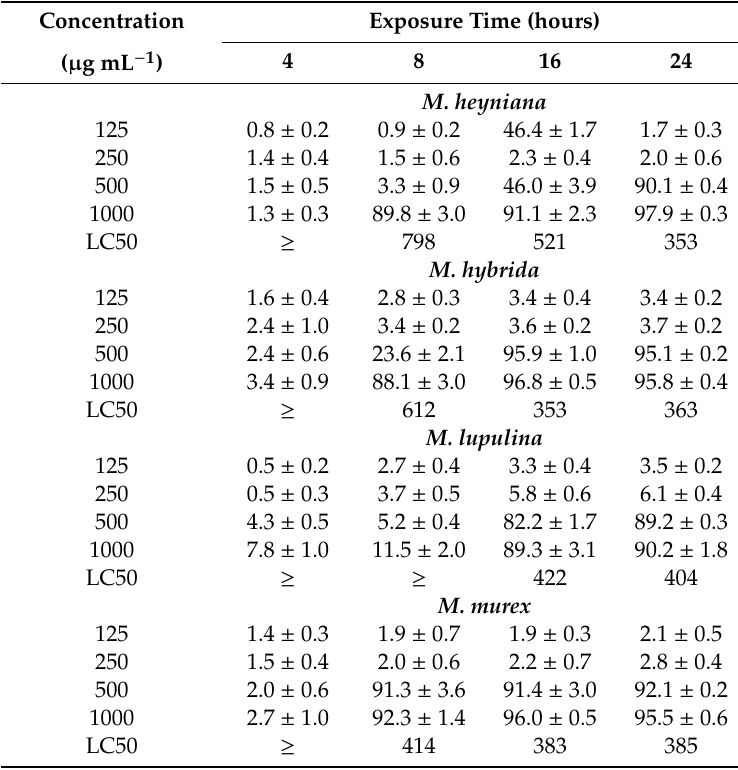
Table 4. Mortality (%) of M. incognita J2 after 4 to 24 h exposures to 125–1000 µ g mL − 1 solutions of the saponin extract from five di ff erent Medicago species (means ±